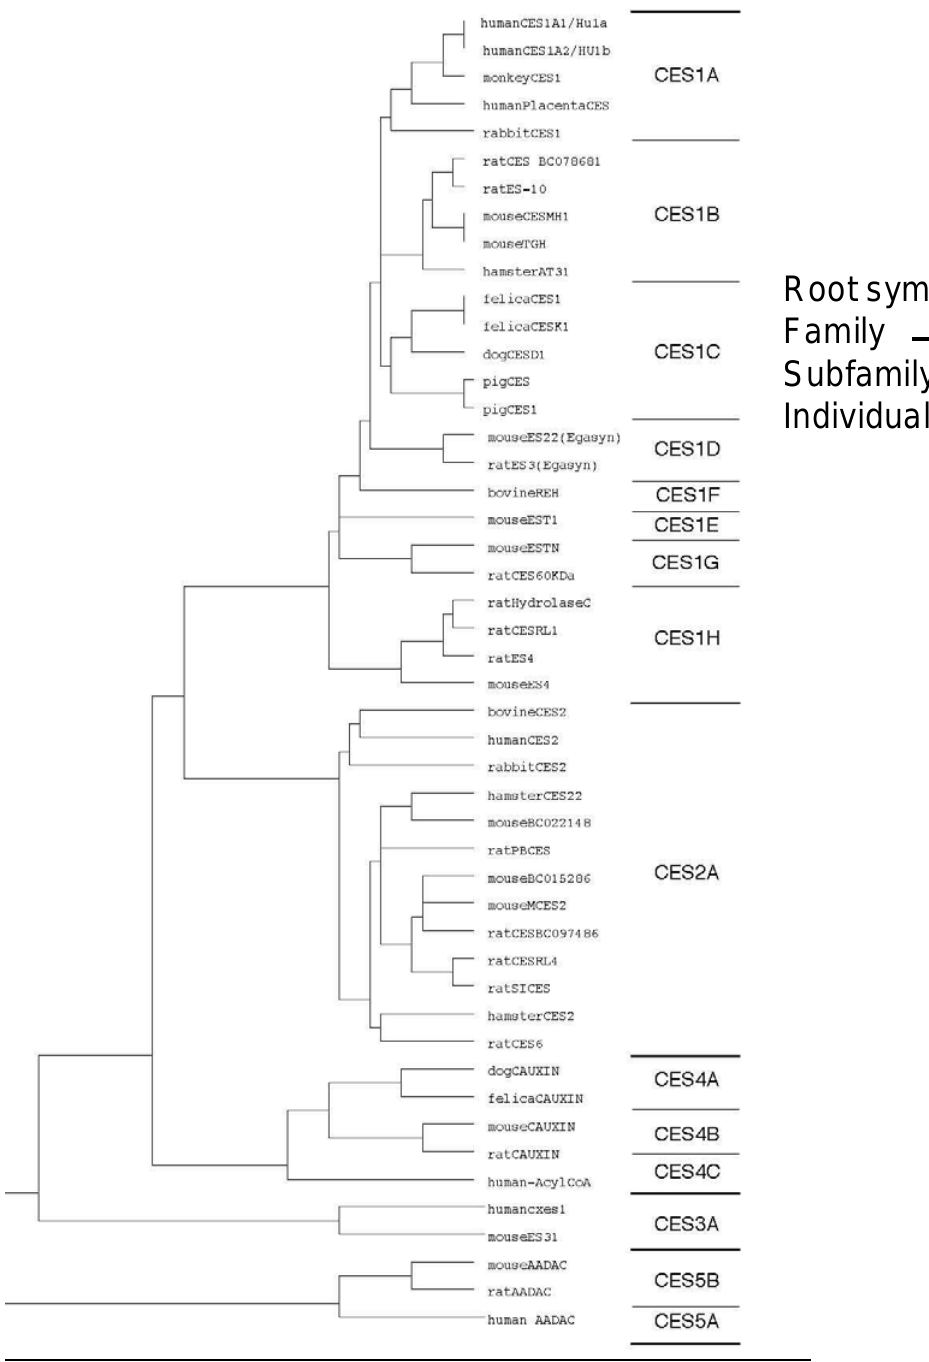
Figure 2 . Phylogenic tree and nomenclature of CES families. CES isozymes are classified into five families, CES1, CES2, CES3, CES4 and CES5. Each families also divided into